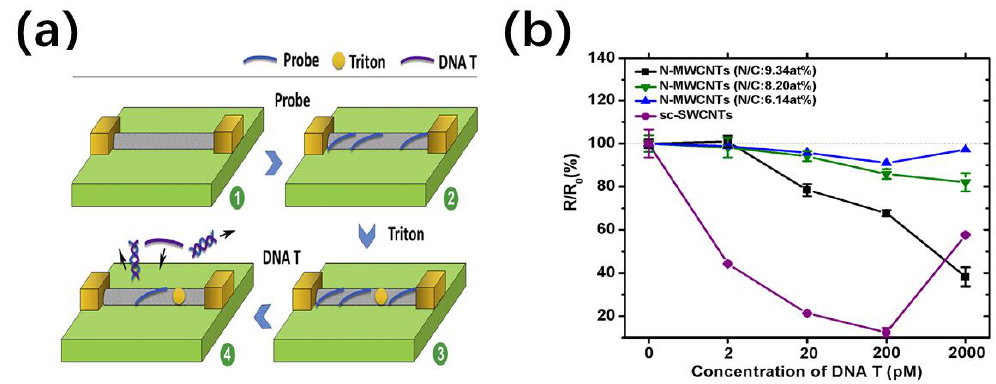
Figure 10. ( a ) Schematic illustration of the functionalization and sensing of the CNT-based biosensor [103]; ( b ) the response of N-doped MWCNTs with various N/C and sc-MWCNTs versus DNA concentration [103].